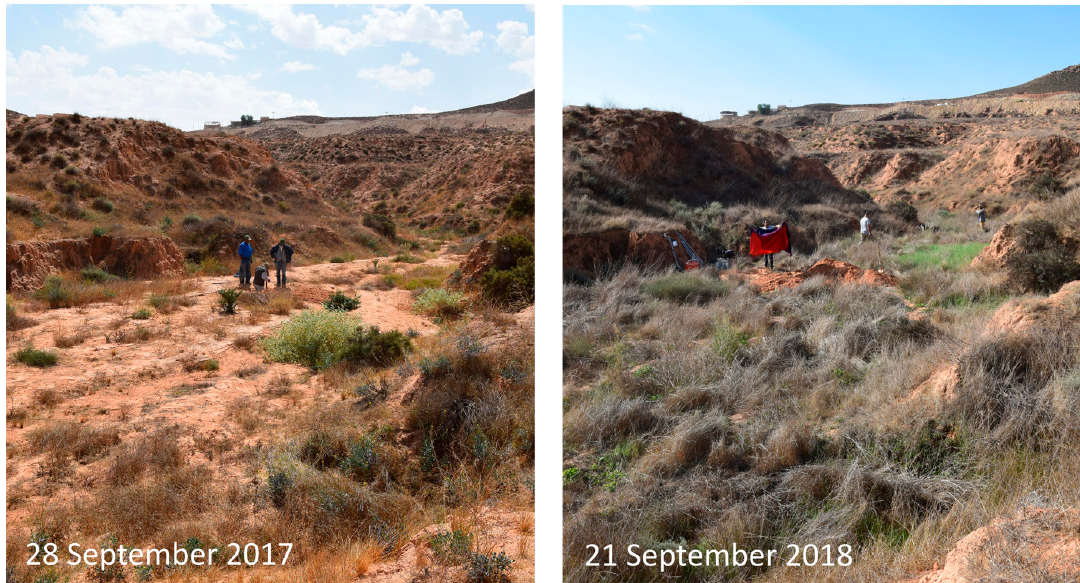
Figure 10. Difference in vegetation cover in the gully between 28 September 2017 and 21 September 2018. Photos: Martin Calianno.